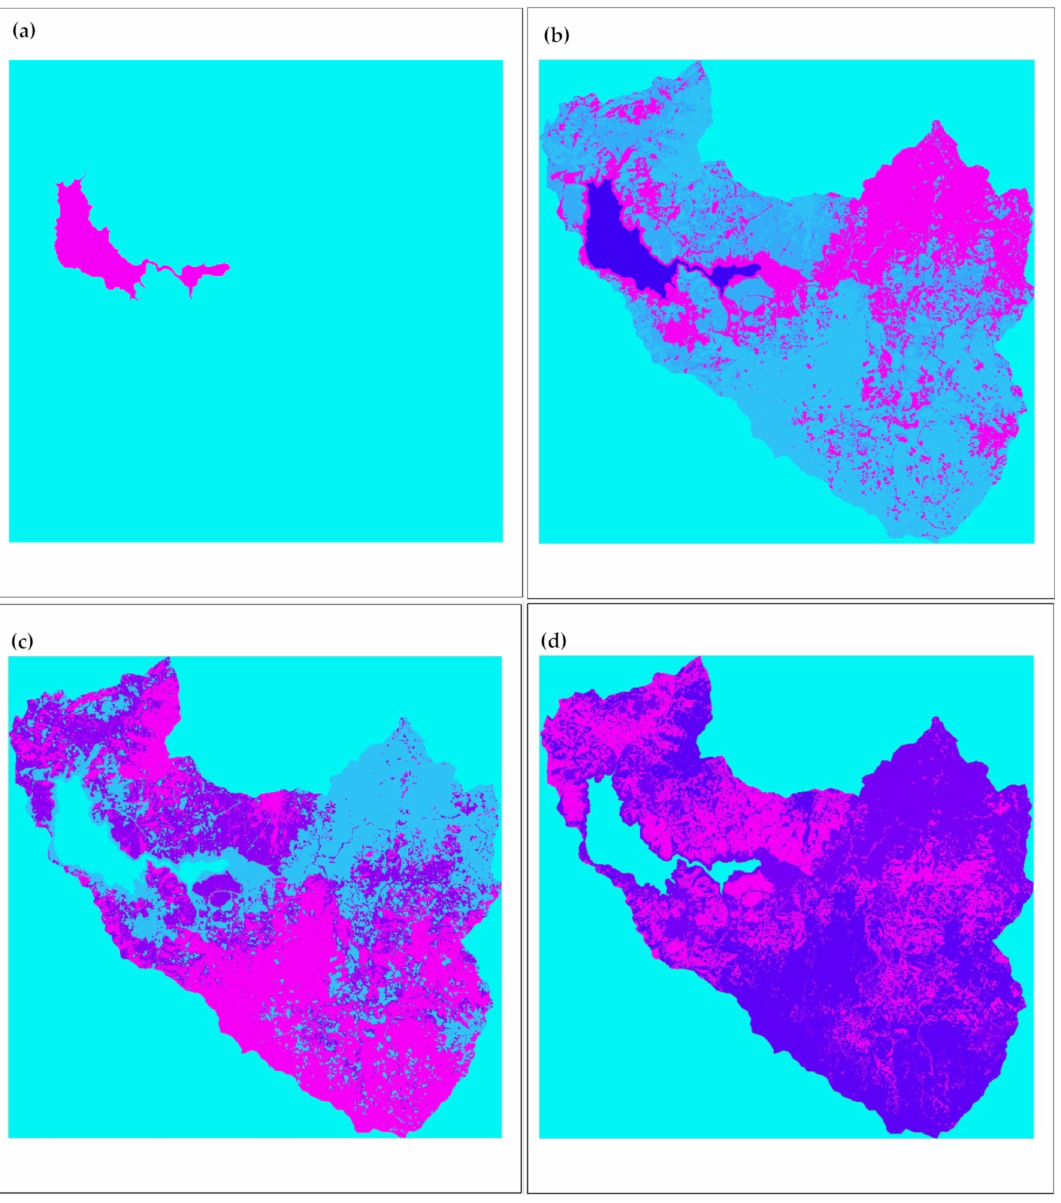
Figure A1. ( a ) Waterbody “land suitability” for the year 2028; ( b ) Bareland “land suitability” for the year 2028; ( c ) Forest “land suitability” for the year 2028; ( d ) Agricultural “land suitability” for the year